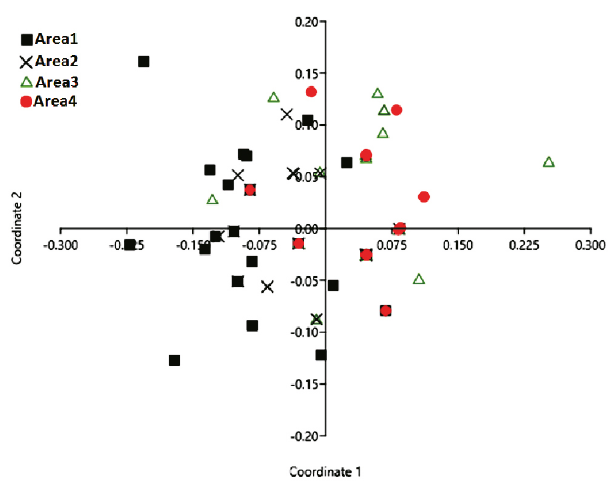
FIGURE 4 | Non-Metric Multidimensional Scaling (NMDS) analysis concerning impacts over the ichthyofauna in the four sampled areas on the Sub-Middle and Lower São Francisco.